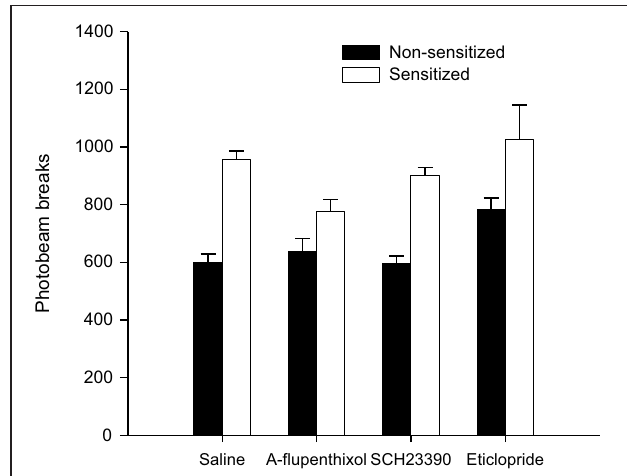
FIGURE 6 | Activity assay—total mean photobeam breaks following a 0.5mg/kg amphetamine challenge in sensitized (white bars) and non-sensitized (black bars) animals treated with saline, α -flupenthixol, SCH23390 or eticlopride during